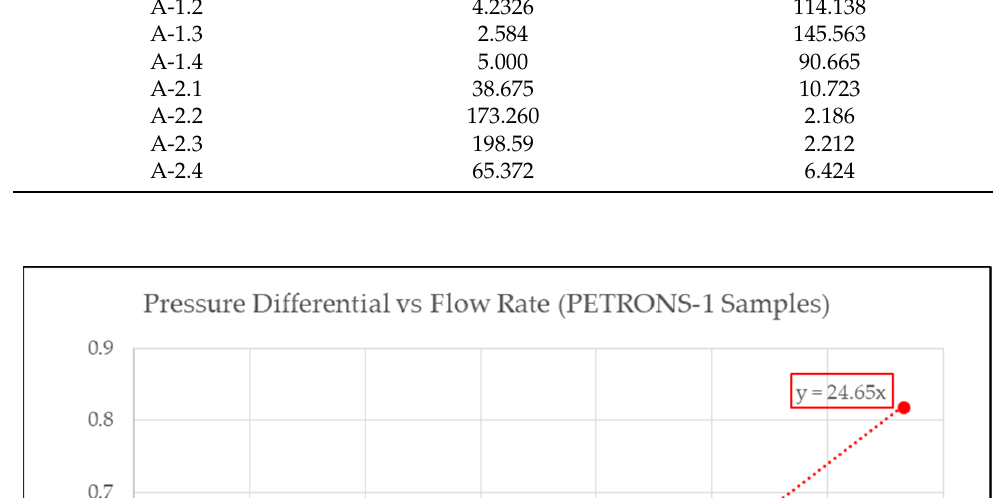
Figure 13. Graph of pressure differential against brine flow rate for PETRONS-2 samples.